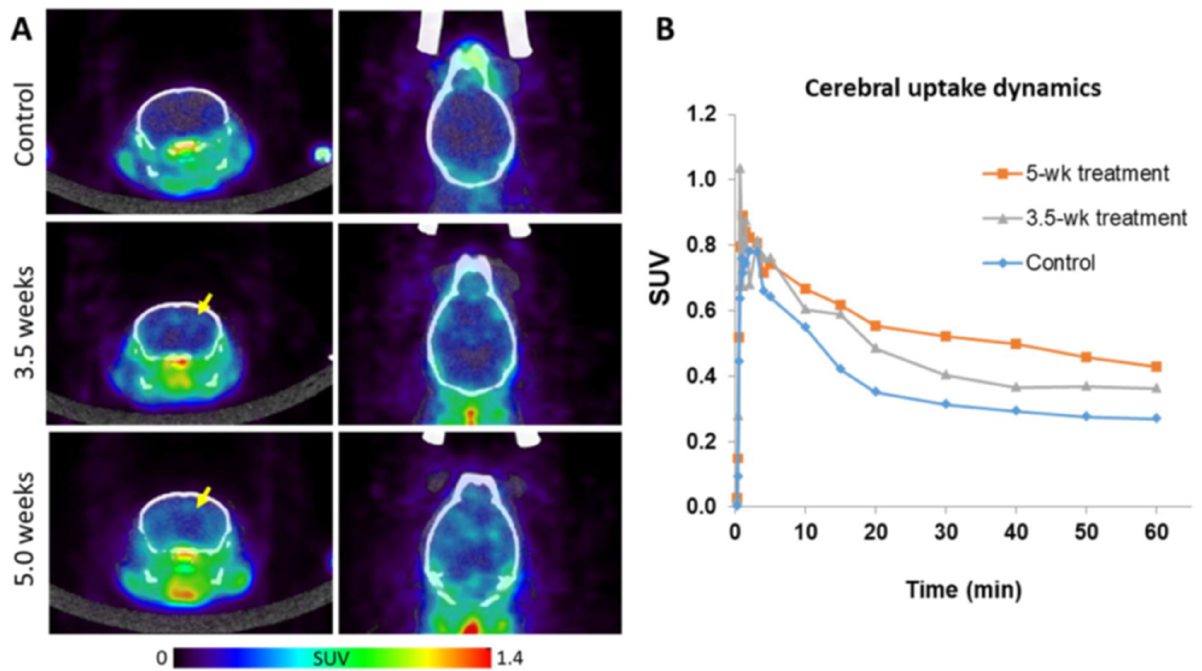
Figure 3. PET/CT images in control, 3.5, and 5.0 weeks cuprizone fed (CF) mice and the uptake dynamics. ( A ) PET/CT images reveal no visible uptake in the control group (top row), but increased brain uptake in 3.5 week (middle row) and 5.0 week (bottom row) CF mice, but less uptake in the brain than in the body (green regions). ( B ) The dynamic uptake curves of 18 F-PBR-111 in the cerebral region over 60 min post injection demonstrate the initial rapid vascular input followed by tissue binding and washout dynamics. The signal was stabilized around 40 min post injection. Subsequent static PET imaging and quantification was conducted at 40 min post injection.